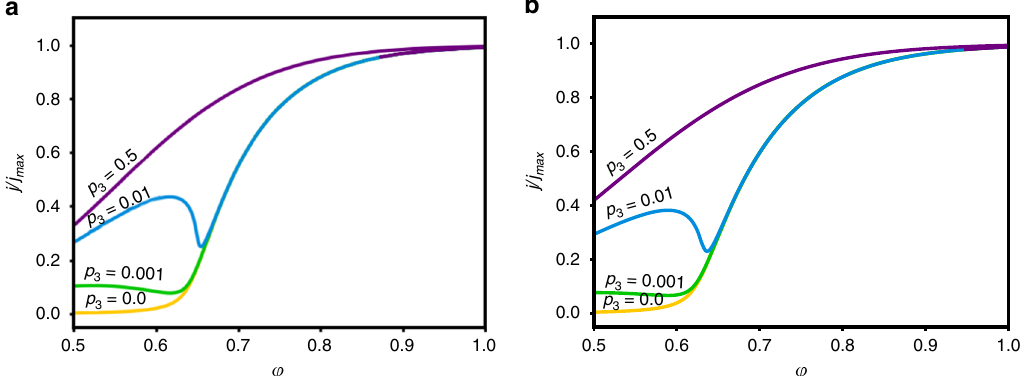
Fig. 4 Numerically computed normalized photocurrent voltammograms at different H 2 O 2 concentrations ( p 3 ). All the observables are dimensionless. The photocurrents are calculated for two cases in which p 1 is a with linear dependence on the applied potential, or b constant (see text and Model equations and numerical computations in Methods section for